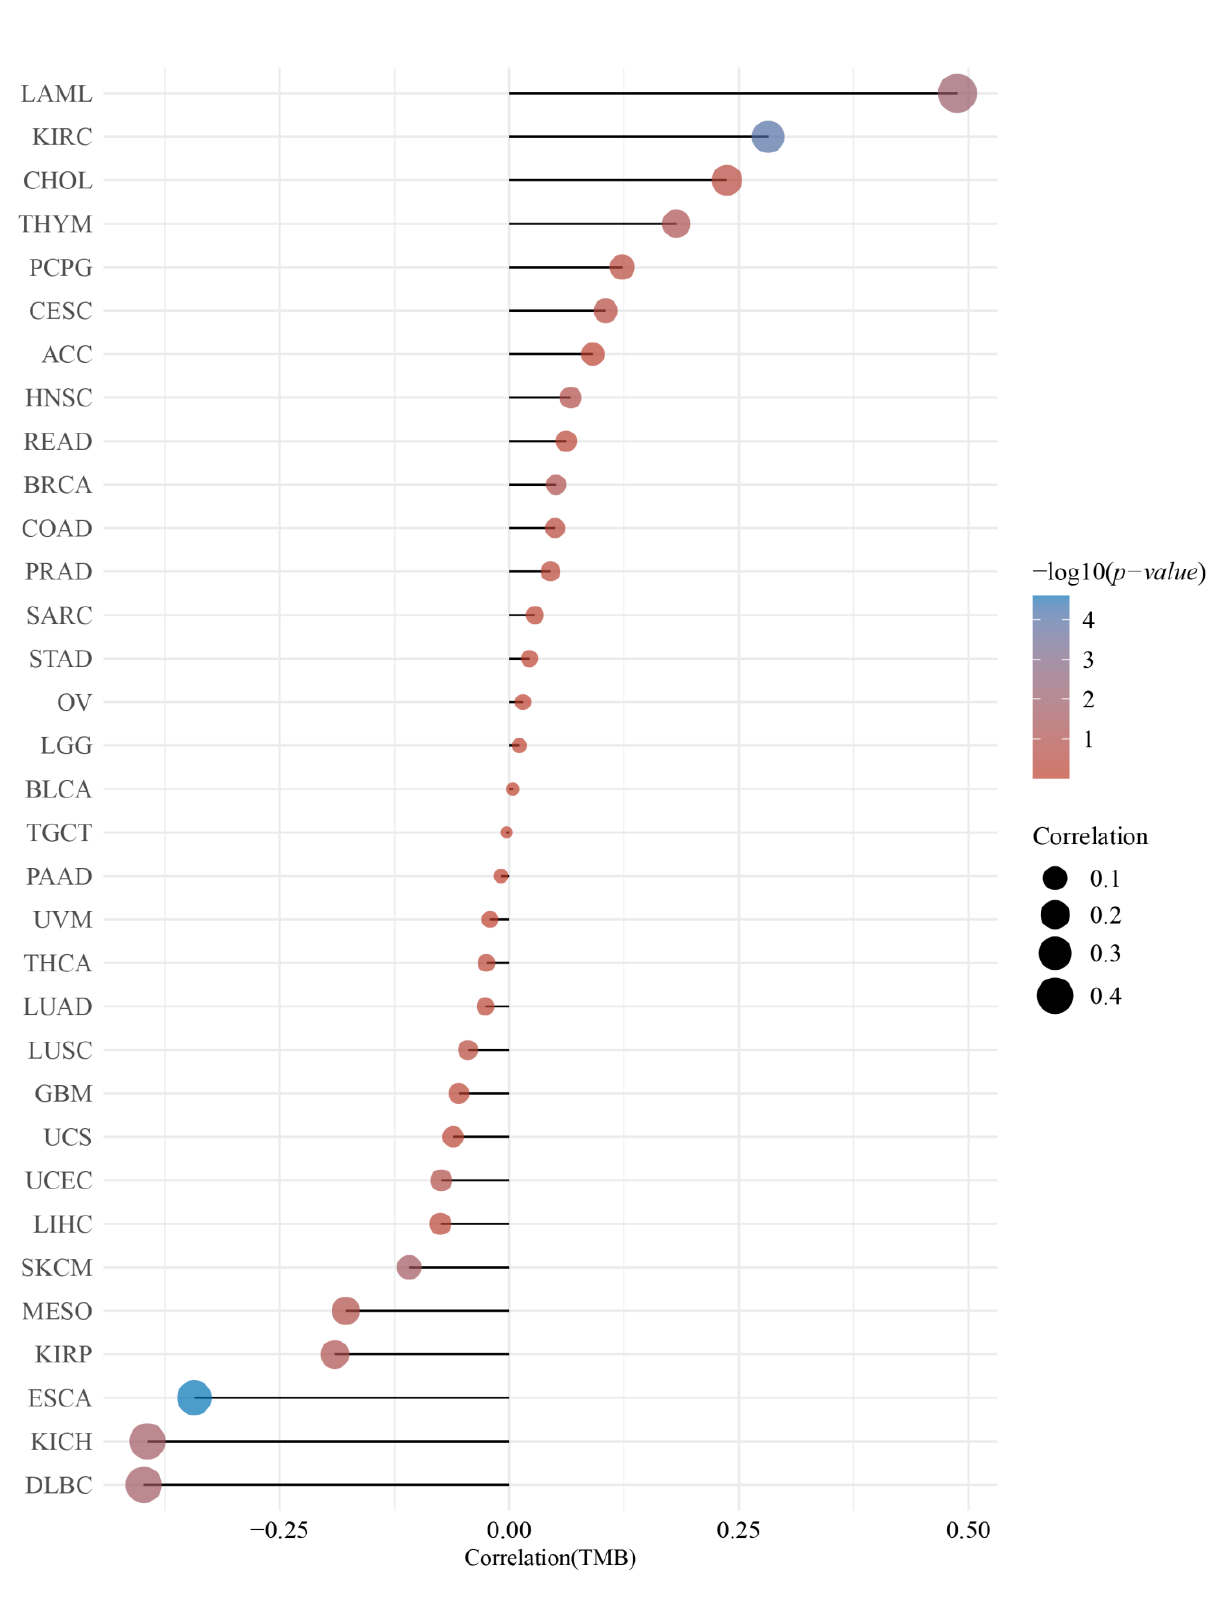
Figure 5. Correlation between the DMRT3 expression and the tumor mutational load (TMB) in pan- cancer tumors (Spearman analysis). The horizontal coordinates represent the correlation coefficients between DMRT3 and TMB, the vertical coordinates are for different tumors, the dot sizes represent the correlation coefficients, and the colors represent the significance of the p -values, with blue representing a smaller p